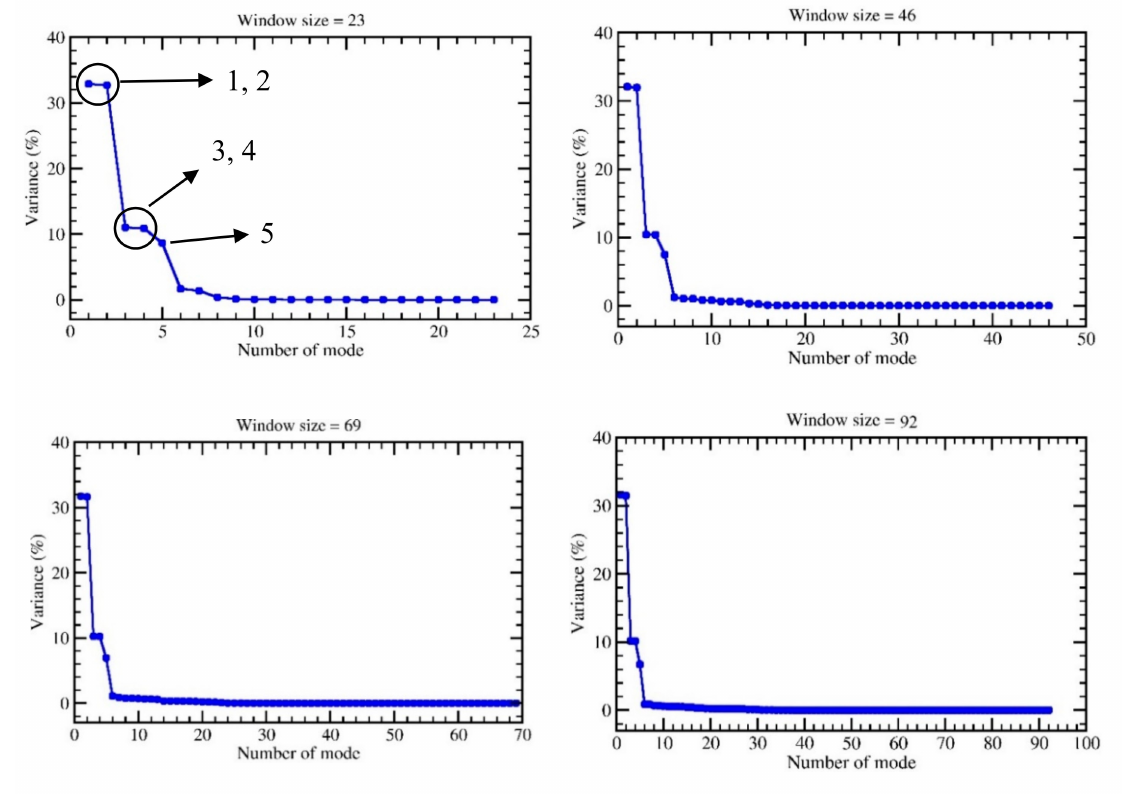
Figure 7. Normalized singular values with 23, 46, 69 and 92 image window size.